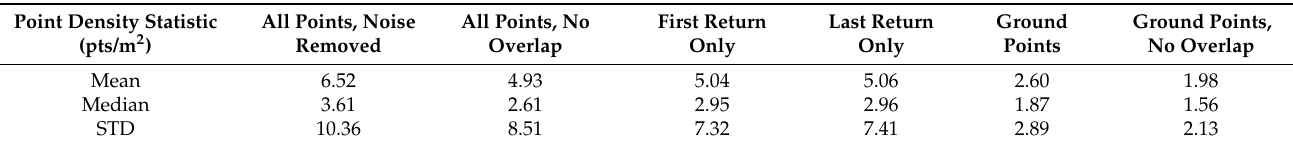
Table 11. Sampled point density calculations (pts/m 2 ) based on the stratified random sampled tiles ( n = 838,858). STD = Standard